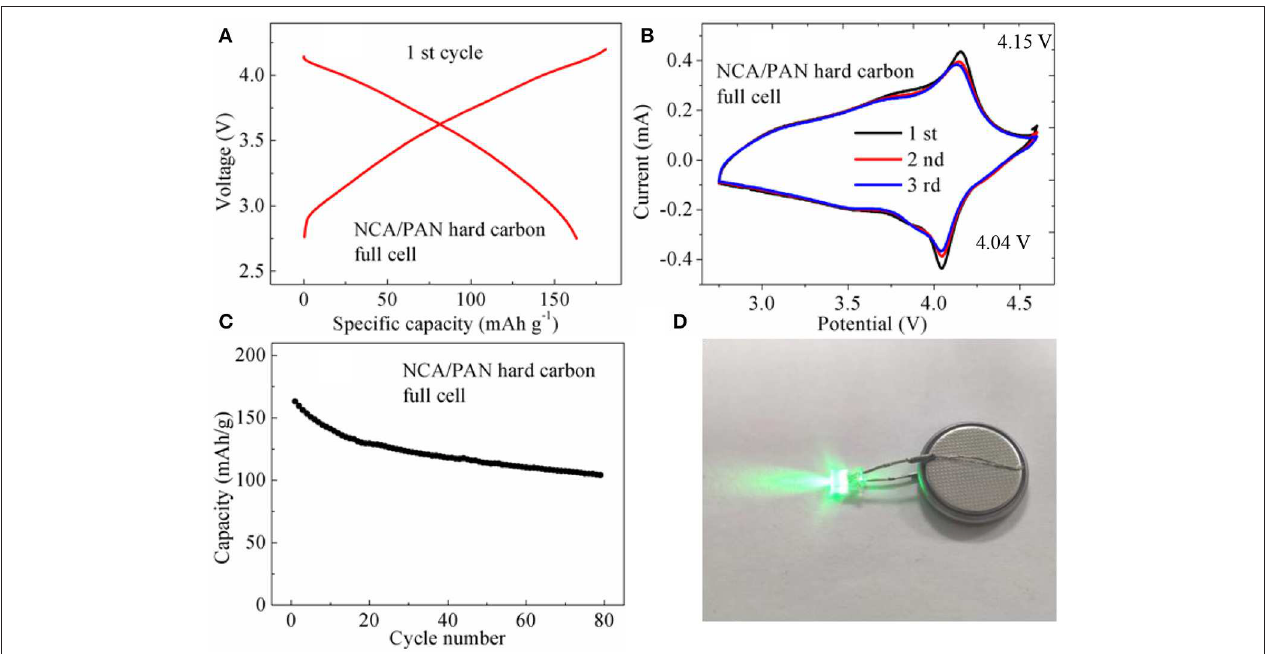
FIGURE 6 | (A) Initial charge and discharge performance of NCA/PAN hard carbon full cell; (B) Cyclic voltammetry curves of NCA/PAN hard carbon full cell; (C) Cycle performance of NCA/PAN hard carbon full cell; (D) Physical diagram of full battery driving LED